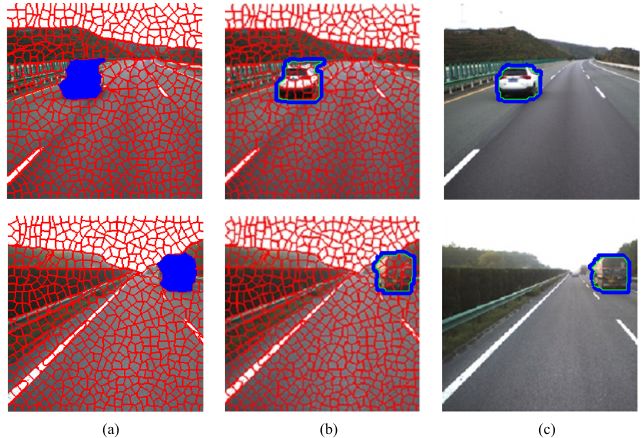
Figure 4. Region refinement based on the FTC level set. ( a ) the superpixel-level RW results; ( b ) the original region contours; ( c ) the refined region contours. The region detection algorithm based on a superpixel-level RW with FTC refinement is summarized in Algorithm 1. Algorithm 1 Region detection based on a superpixel-level RW with FTC